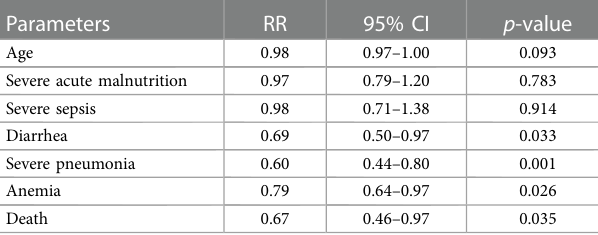
TABLE 2 Results of log-linear binomial regression analysis to understand the real impact of immunization among children from the age of 4 to 59 months hospitalized for pneumonia and severe